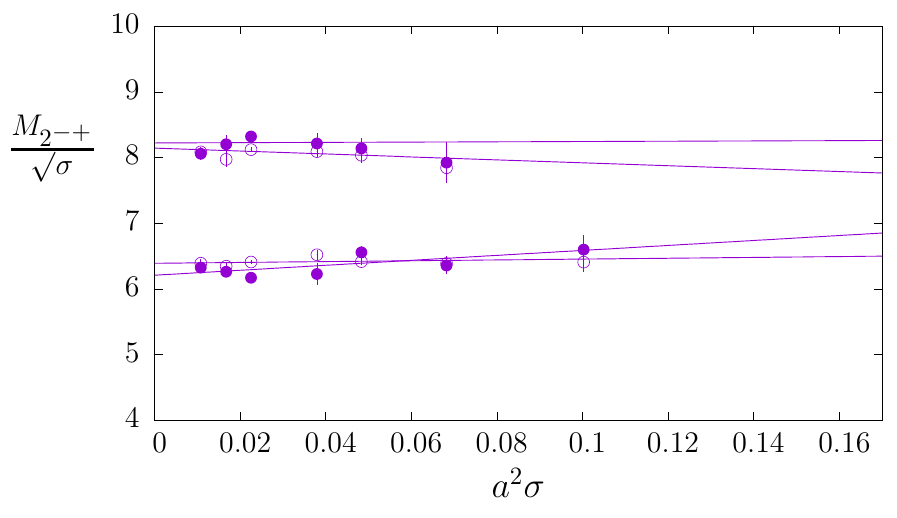
Figure 17 . Continuum extrapolations of the lightest two J PC = 2 − + glueballs, as obtained from the lightest two E − + states ( • , each doubly degenerate) and the lightest two T 2 − + states ( ◦ , each triply degenerate). Hence the five components of each of the two J = 2 states.